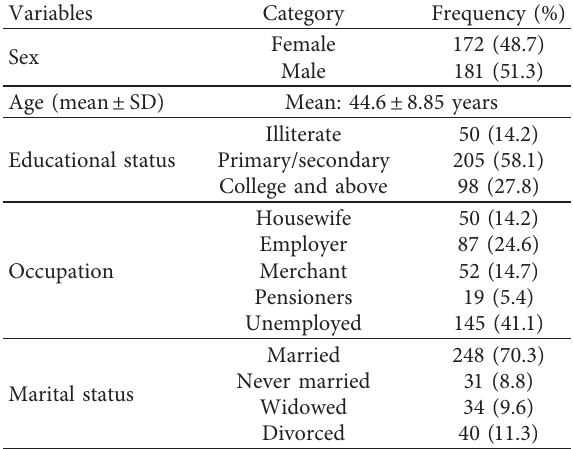
Table 3: Laboratory and anthropometry-related parameters among HIV patients who received ARTat armed force comprehensive and specialized hospital, Ethiopia, 2018 ( n � 353).